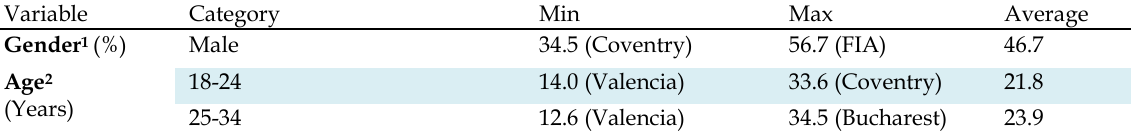
Table 4. Distribution of sample by test